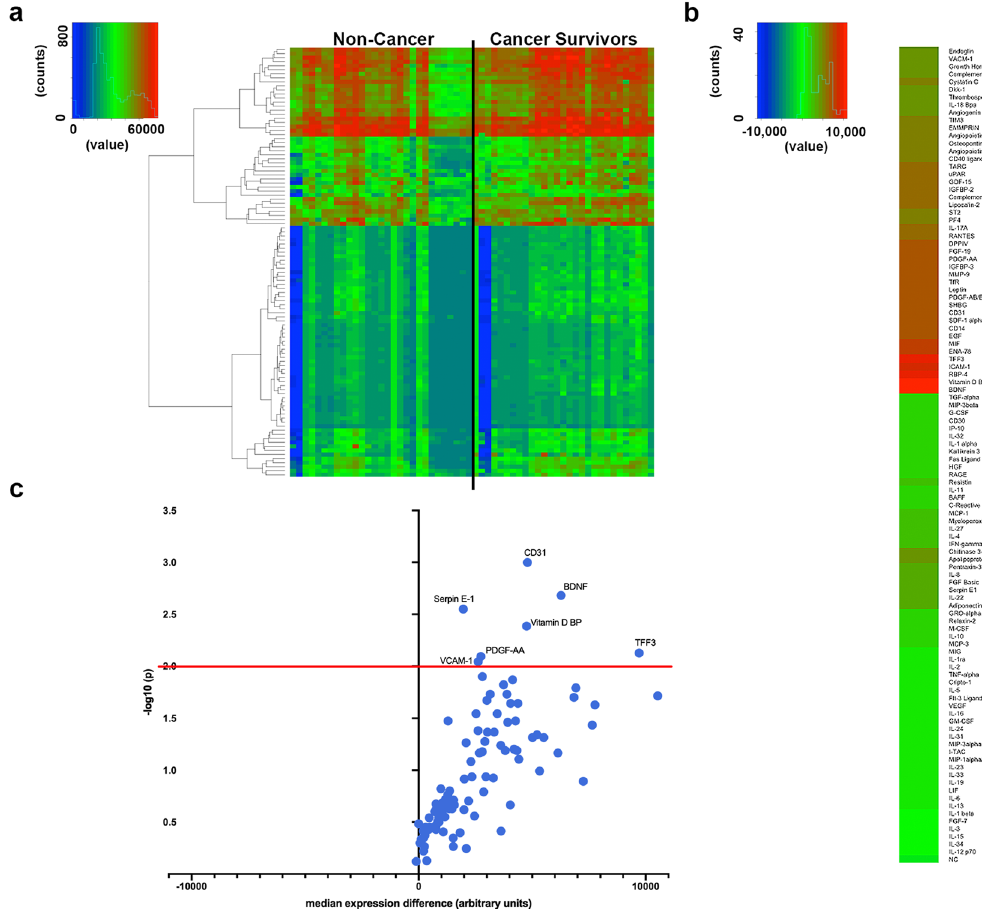
Figure 2. Serum cytokine expression in cancer survivors and non-cancer participants. ( a ) Heatmap depicting cytokine expression among cancer survivors and non-cancer participants. ( b ) Individual cytokine differences between cancer survivors and non-cancer participants. Higher (red) to lower (green) differences among groups. ( c ) Volcano plot depicting cytokine changes (x-axis) and p-values (statistical significance was established as p < 0.01;